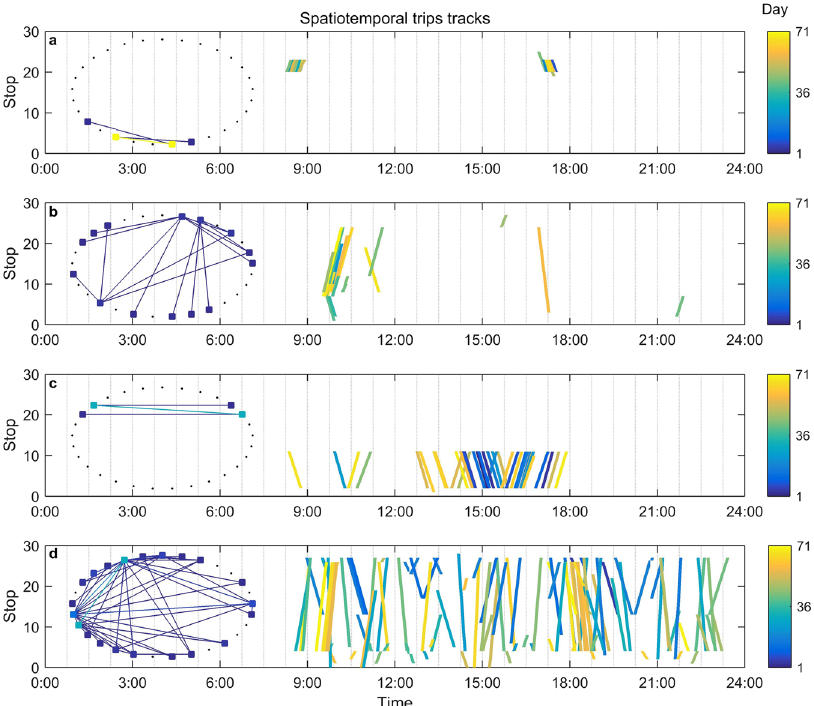
Figure 1. Individual spatiotemporal trip tracks. Each line segment in a specific panel represents a trip of the individual, where the left end indicates the trip origin and the right end indicates the trip destination. Every end point is located corresponding to its boarding or alighting time on the horizontal axis and stop on the vertical axis. The line segments are colour coded to illustrate the passage of time from day 1 to day 71 within the observation period. ( a ) The individual travels at an almost fixed time from a certain stop to another certain stop in the mornings and turns backwards in the afternoons. ( b ) The individual’s trips mostly occur at a stationary time but with diverse origins and destinations. ( c ) The individual always travels between two fixed stops but with a fairly large time diversity. ( d ) The individual’s trips are highly random. A subplot is provided in each panel to serve as a sketch map showing the origin-destination pairs of each individual with the colour bar